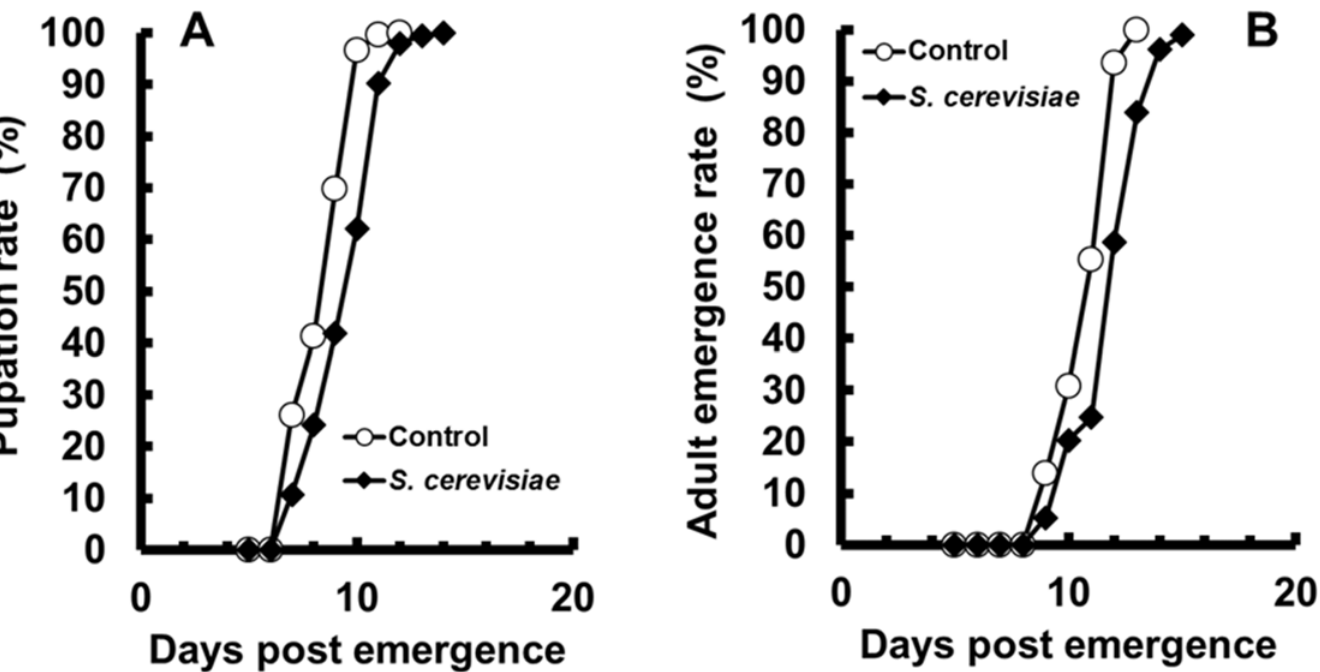
Fig 1. Life parameters of Aedes aegypti larvae fed since egg hatching exclusively with cat food or Saccharomyces cerevisiae live cells. Percentage of pupation (A) and percentage of emergence of adults (B). Figures are means of 4 experiments with 80 larvae each.